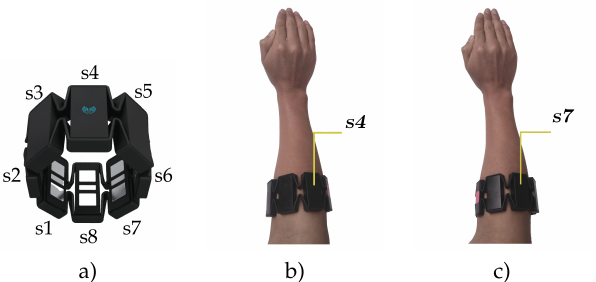
Figure 2. Myo armband sensor. ( a ) Myo pod distribution, ( b ) position of the sensor suggested by the Myo manufacturer, and ( c ) position of the Myo sensor rotated, which can cause issues during the recognition procedure.